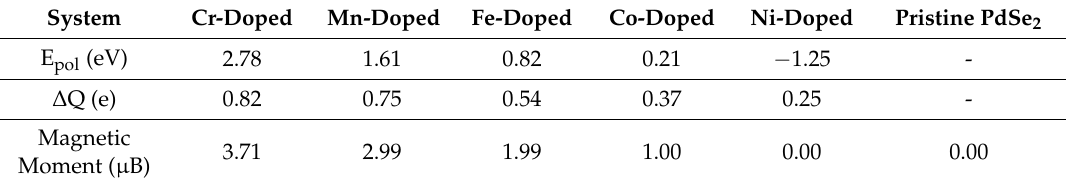
Table 1. Calculated spin polarization energy, charge transfer and magnetic moments of PdSe 2 with different